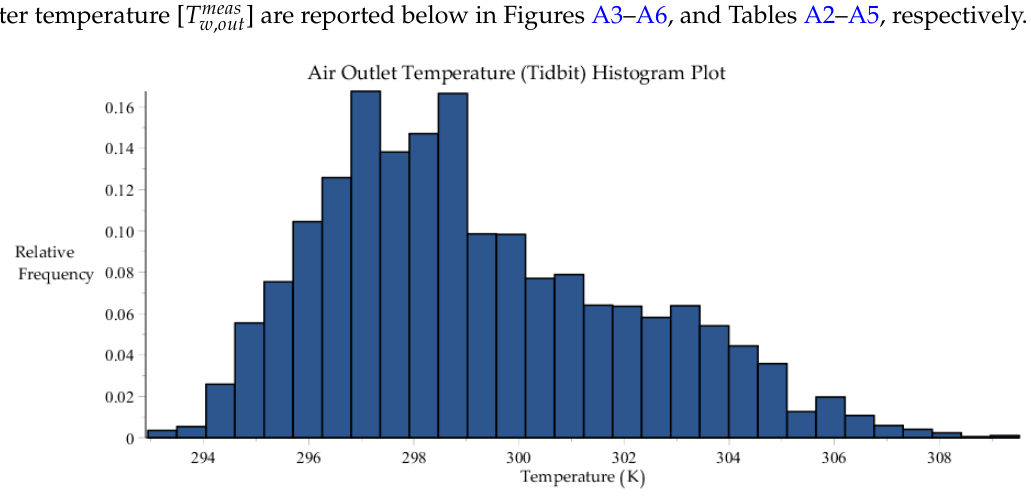
Figure A3. Histogram plot of the air outlet temperature measured using “Tidbit” sensors, within the 6717 data sets collected by SRNL from F-Area cooling towers.